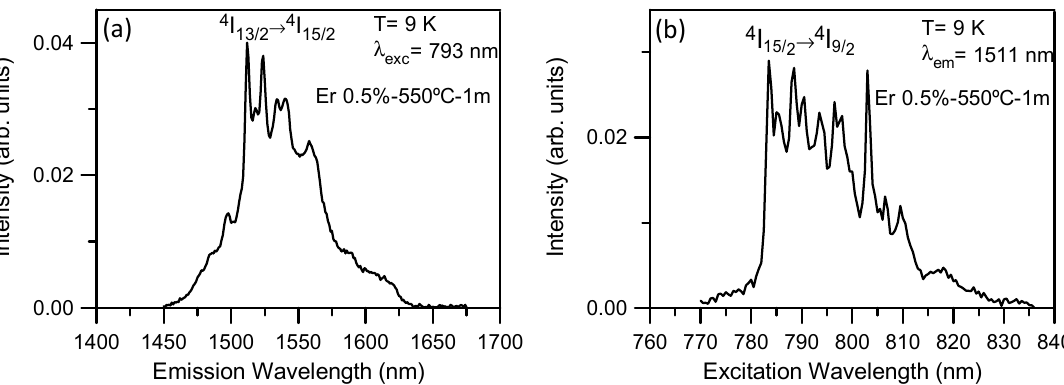
Figure 10 . ( a ) Low temperature emission spectrum of 80SiO 2 -20LaF 3 -0.5Er 3+ (TEOS-MTES) bulk sample heat treated at 550 ° C for 1min on exciting at 793 nm. ( b ) Low temperature excitation spectrum obtained at 1511 nm.